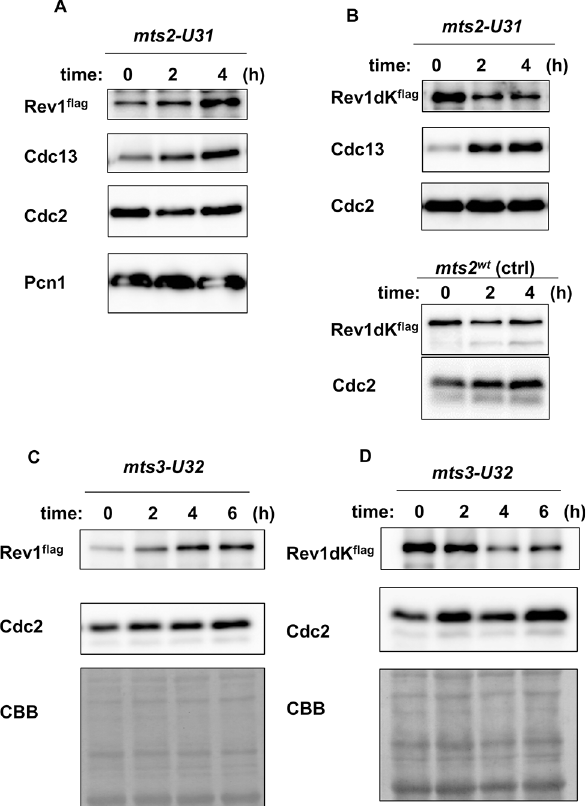
Fig 3. Rev1 protein was stabilized under the restrictive condition for the mts2 or mts3 temperature- sensitive mutant. A, Protein level of Rev1 was increased after the temperature shift in the mts2 temperature-sensitive mutant. The mts2-U31 mutant, harboring-flag tagged Rev1, was first grown at 25°C, and the temperature was then shifted to 36.5°C. Samples were collected every 2 h until 4 h after the shift. Whole cell extracts were prepared. The panels show the protein expression of Rev1, Cdc13, Cdc2, and Pcn1. B, The protein level of Rev1dK did not increase at the restrictive temperature of mts2-U31 . The panels show the protein expression of Rev1dK, Cdc13, and Cdc2 in the mts2-U31 strain, and that of Rev1dK and Cdc2 in the mts2 wt control. The lanes represent the protein expression at 0, 2, and 4 h after the temperature shift in the mts2-U31 or mts2 wt strain. C, The protein level of Rev1 increased after the temperature shift in the mts3 temperature-sensitive mutant. The mts3-U32 mutant, harboring flag-tagged Rev1, was first grown at 25°C, and the temperature was then shifted to 36.5°C. The samples were collected every 2 h until 6 h after the shift. Whole cell extracts were prepared. The panels show the protein expression of Rev1 and Cdc2, as well as CBB staining of the membrane. D, The protein level of Rev1dK did not increase at the restrictive temperature in the mts3-U32 strain. The panels show the protein expression of Rev1dK and Cdc2, as well as CBB staining of the membrane. The lanes represent the protein expression at 0, 2, 4, and 6 h after the temperature shift in the mts3-U32 strain.